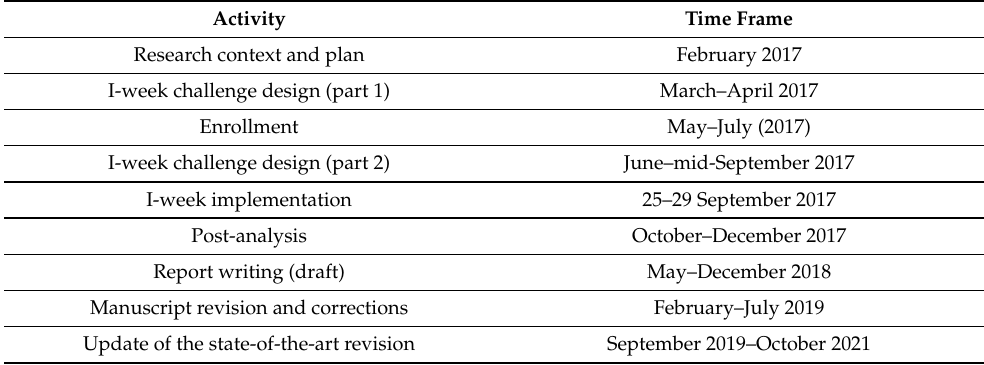
Table 4. Research time